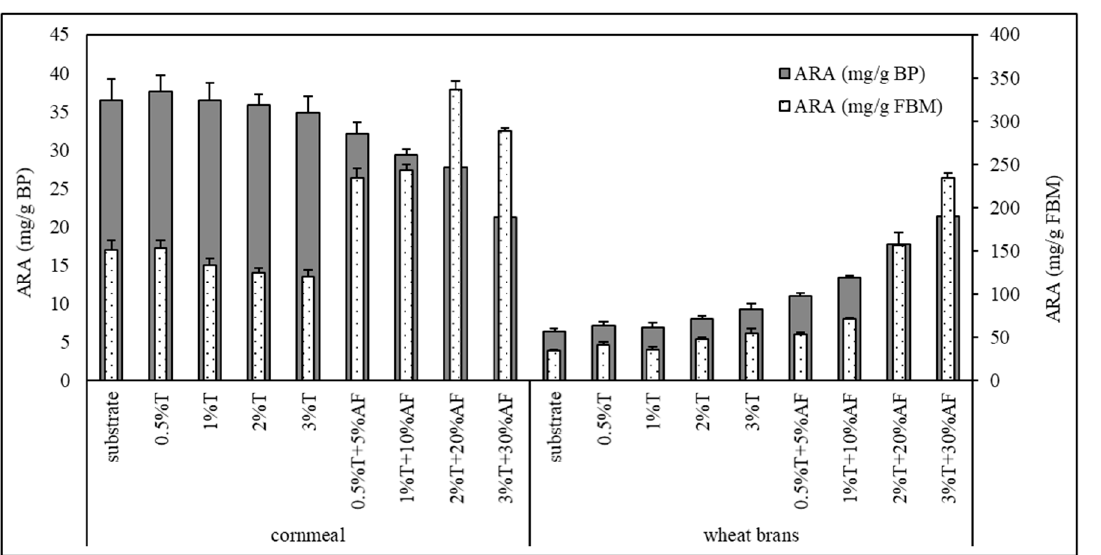
Figure 2. Content of arachidonic fatty acid (ARA) in fermented bioproducts (BP) and in fungal biomass (FBM). T—Tween 40, AF—animal fat by ‐ product. (FBM). T—Tween 40, AF—animal fat